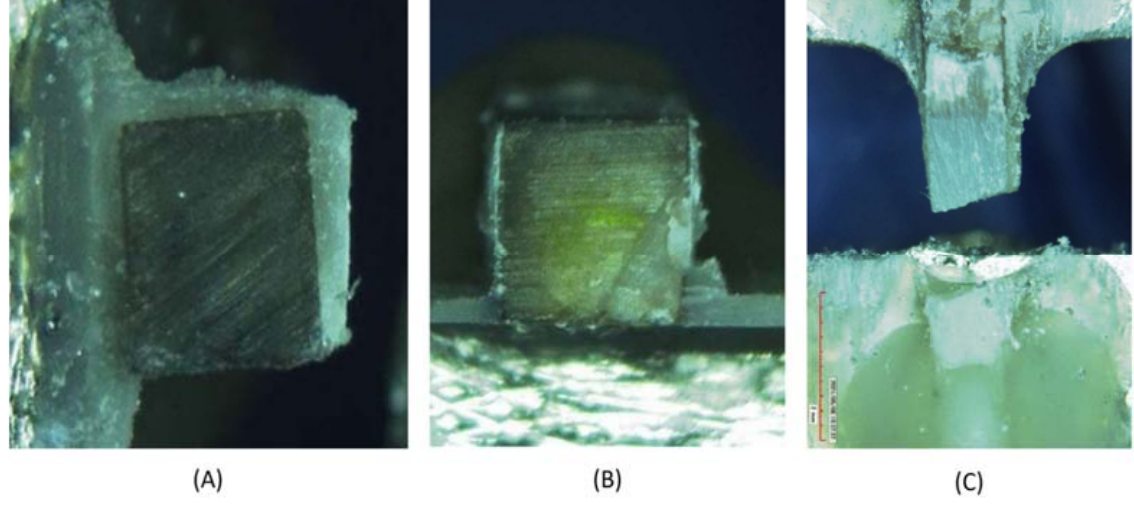
Figure 1. Failure mode distributions for each group. x axis: failure modes; y axis: number of specimens.